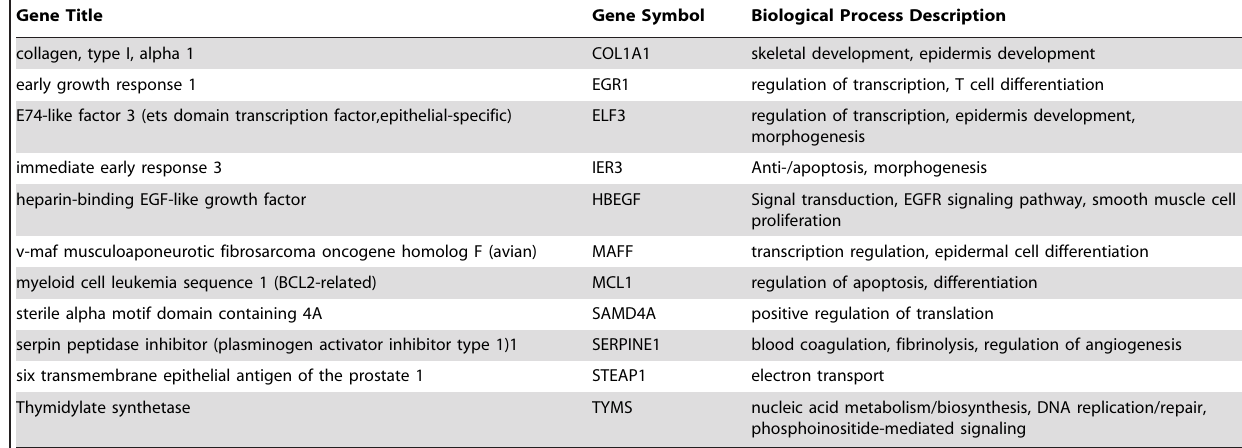
Table 3. Validation gene set.